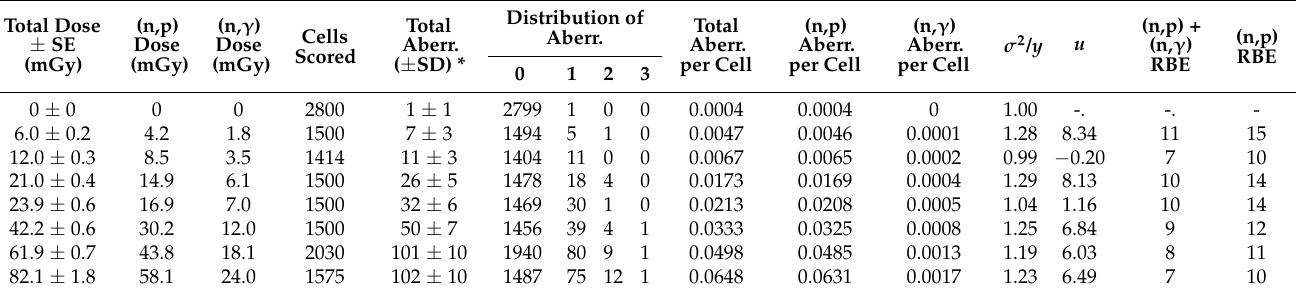
Table 2. DCA aberration distribution in the peripheral blood lymphocytes of three donors and dose-specific RBE values following 64 meV thermal neutron exposure. Values of u demonstrating non-Poisson over-dispersion are highlighted in bold. The dose is reported as the mean dose with standard error (SE).